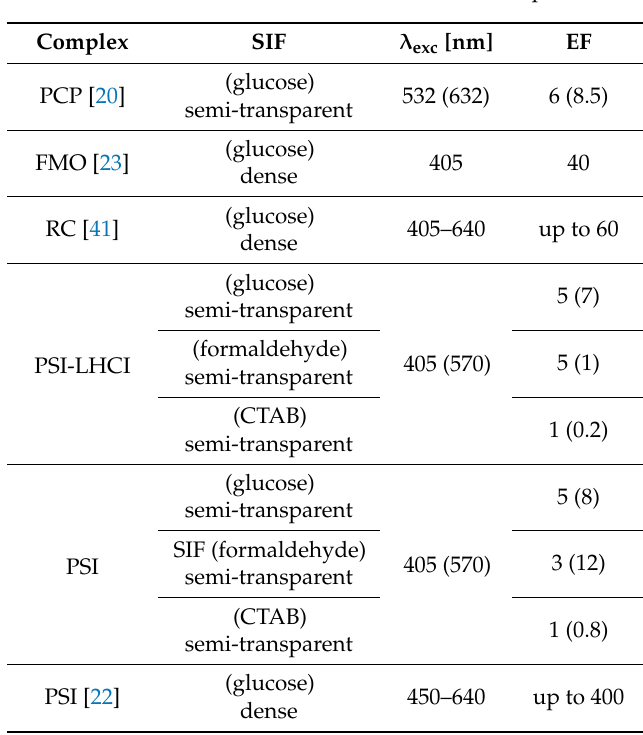
Table 1. Summarized EFs for all considered